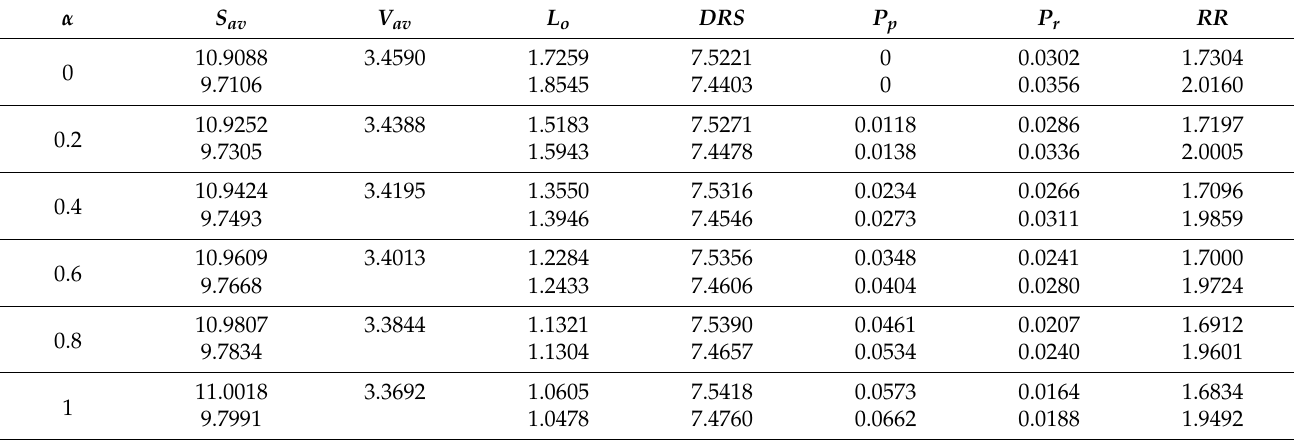
Table 5. Dependence of the performance measures on parameter α ; λ = 20, η = 15, κ = 8, ν = 10, and β = γ = 0.6.